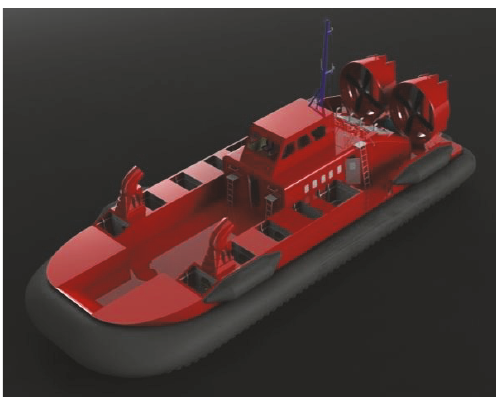
Figure 1: A 3D model of hovercraft. Photo is from the international cooperation project described in the Acknowledgment.